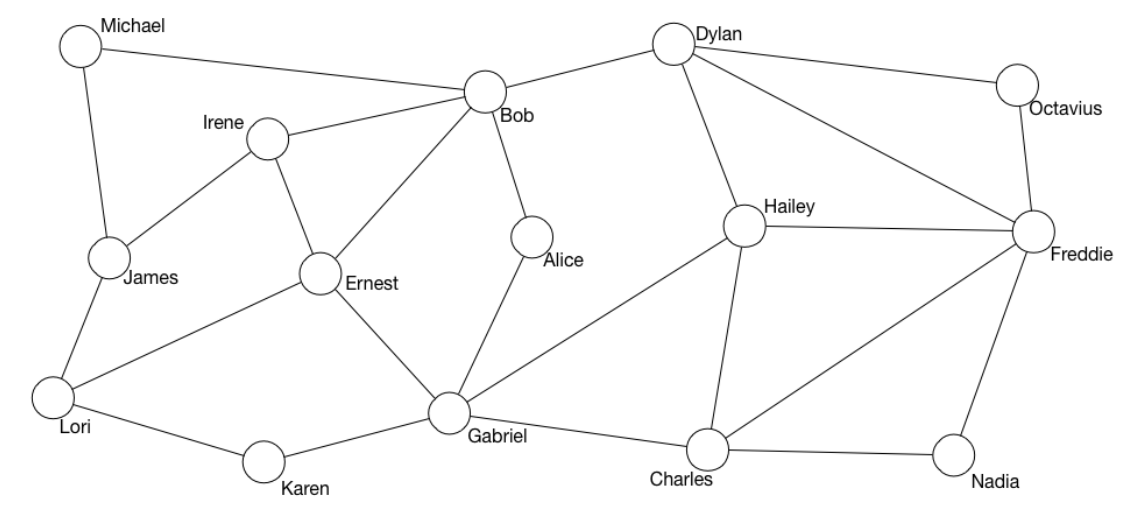
Figure 1. An example of social